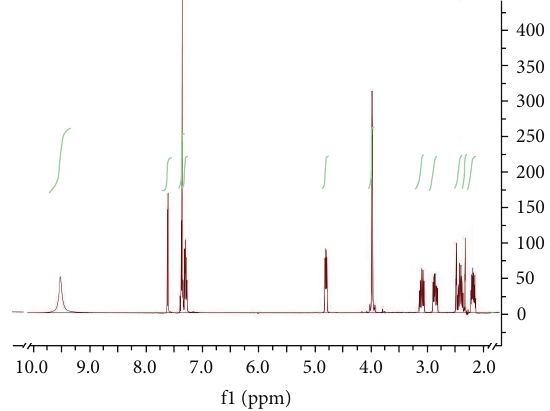
Figure 5: NMR spectrum of RSG mesylate.